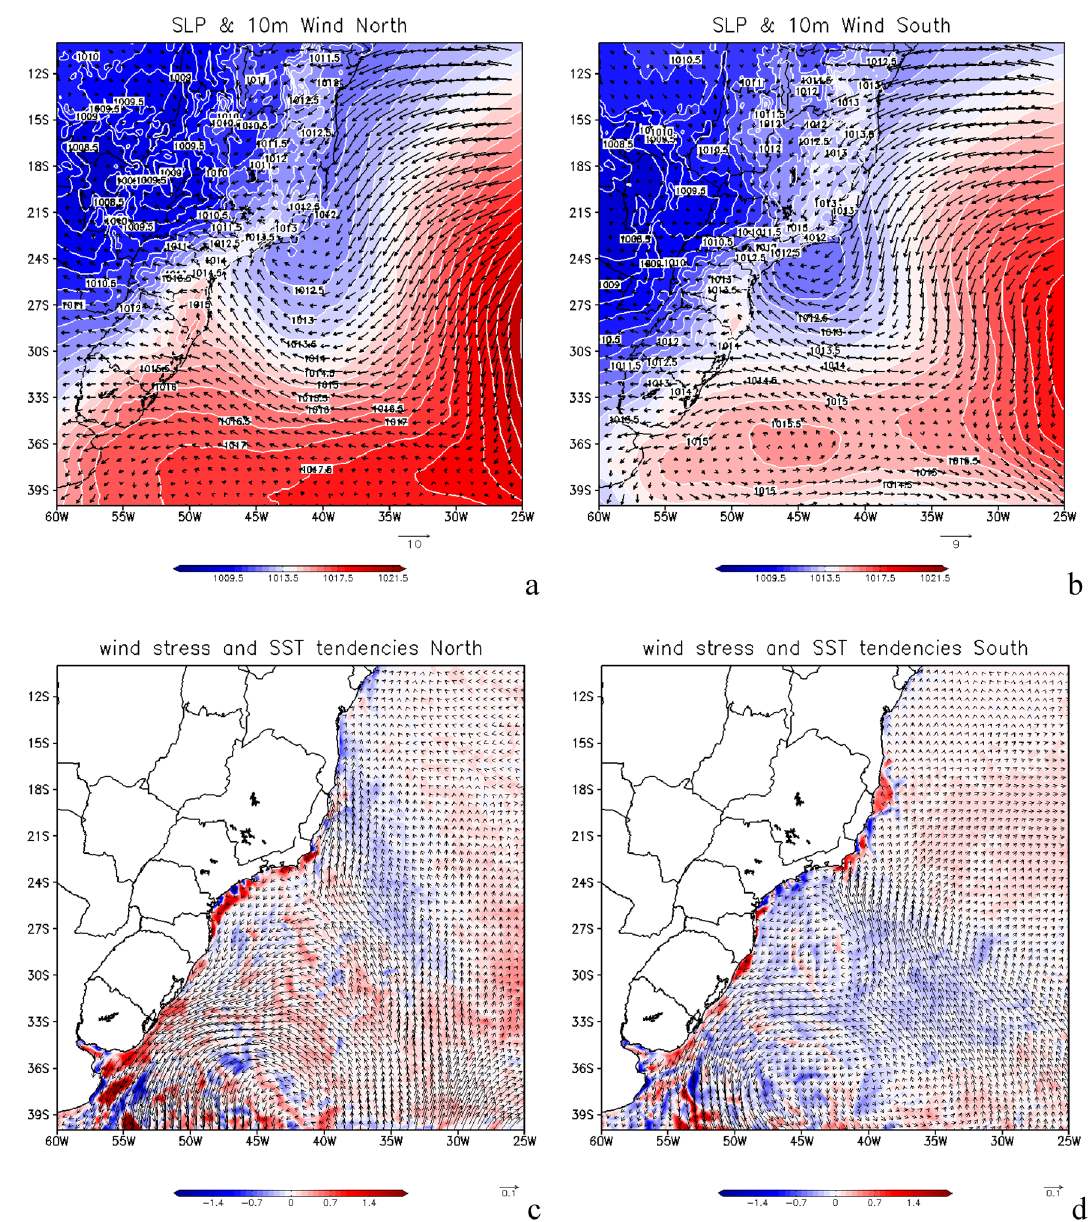
for the three cases where the oceanic South Atlantic Convergence Zone (SACZ) were anchored further north ( a ) and for the four oceanic SACZ cases when they were anchored further south ( b ). Wind stress tendency (N m −2 ) superimposed on Sea Surface Temperature (SST) tendency (°C) for the further north cases ( c ) and for the further south ( d ). Grid Analysis and Display System (GrADS), Version 2.2.1.oga.1. http:// openg rads.